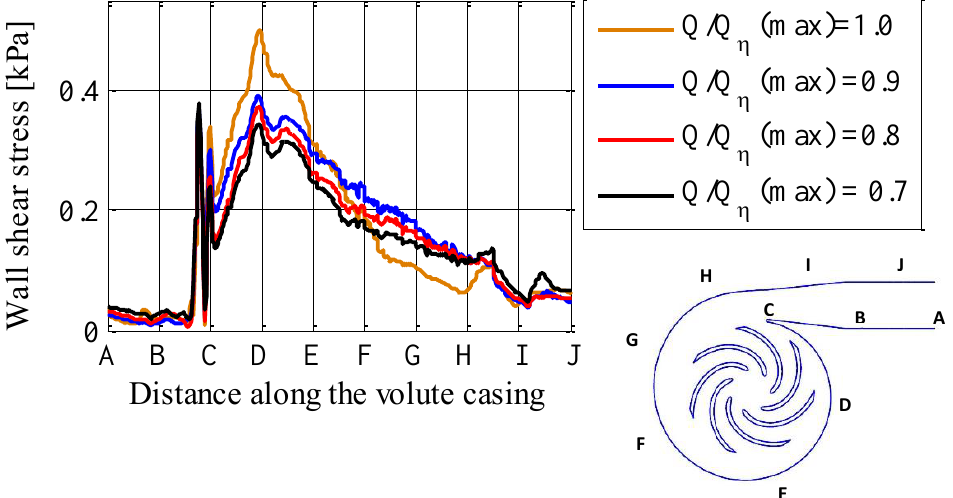
Figure 12. Variation of wall shear stress along the walls of the pump casing at different flow rates.